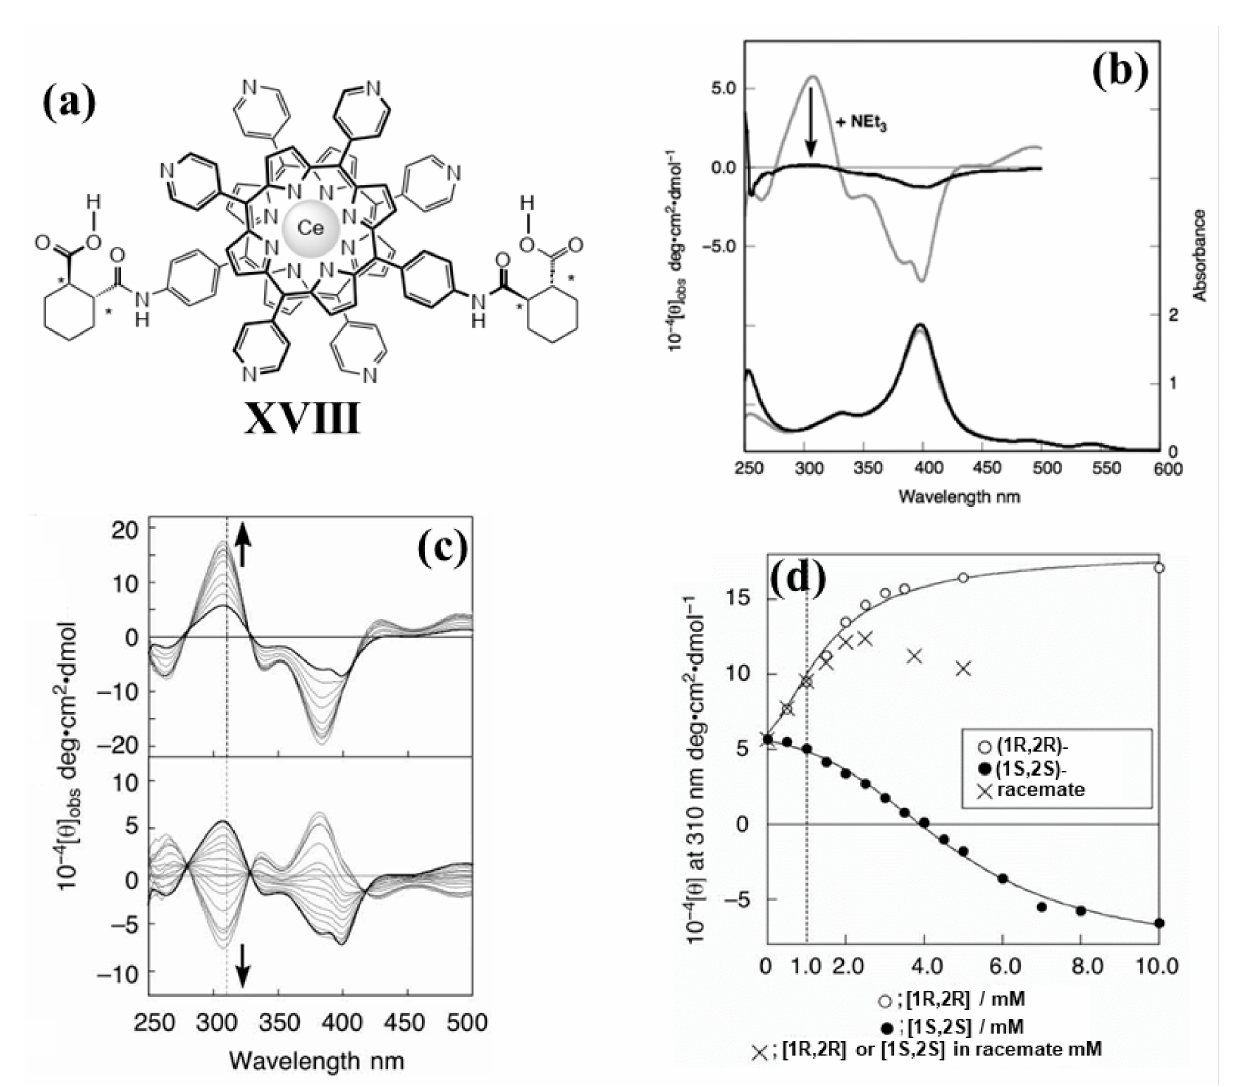
Figure 15. ( a ) Molecular structure of the chiral (R, R-) double-decker porphyrin XVIII . The stereogenic centres are indicated by an asterisk (*); ( b ) CD (top) and UV/Vis (bottom) spectra of porphyrin XVIII in tetrachloroethane-tetrahydrofuran 30:1 ( v / v ) mixed solvent without (grey line) and with triethylamine (black line); ( c ) Titration CD spectra of porphyrin XVIII with an increasing amount of cyclohexane-(1R, 2R)-dicarboxylic acid (top) and cyclohexane-(1S, 2S)-dicarboxylic acid (bottom). The bold lines refer to CD spectra of 1R in the absence of guest; ( d ) Plots of the CD intensity at 310 nm by adding an increasing amount of cyclohexane-(1R, 2R)-dicarboxylic acid (white dots), its chiral counterpart (black dots), and racemic mixture (cross), respectively. Adapted with permission from reference [75]; published by Taylor & Francis